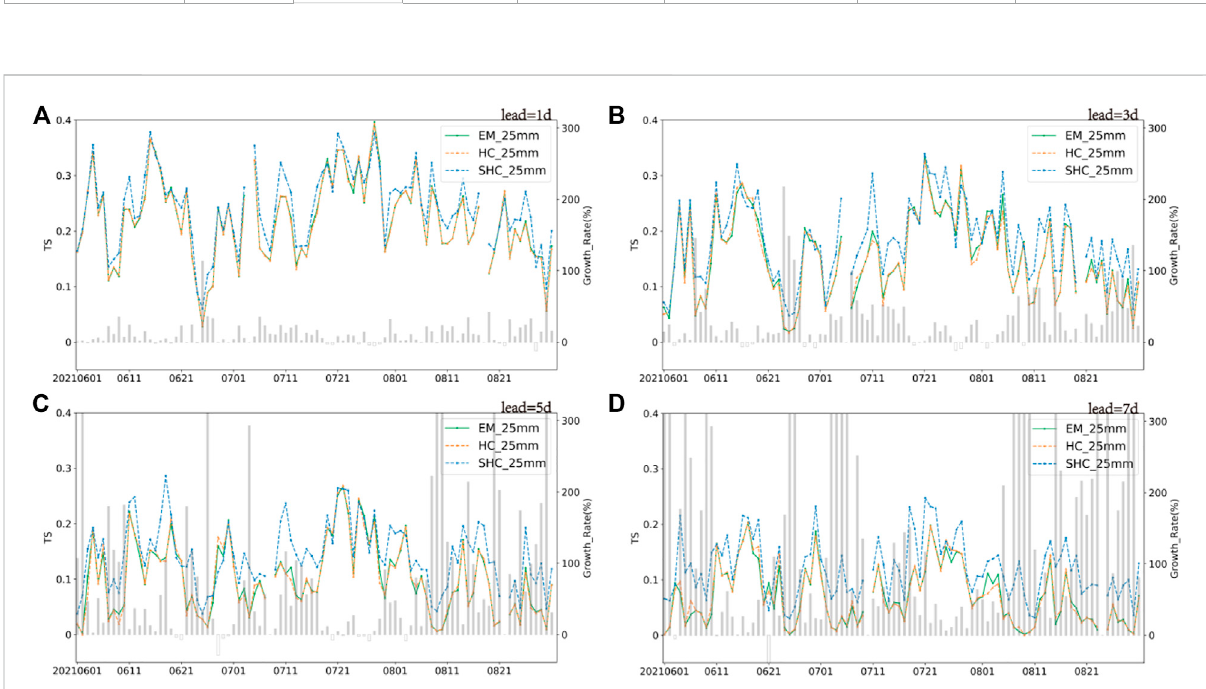
FIGURE 3 Time series of TS and its growth rate related to 25 mm precipitation with lead time of 1 (A) , 3 (B) , 5 (C) , and 7 (D) days in summer 2021; green, orange, and blue lines denote EM, HC, and SHC, respectively, corresponding to the left axis; the grey bars denote the SHC growth rate compared with EM, corresponding to the right